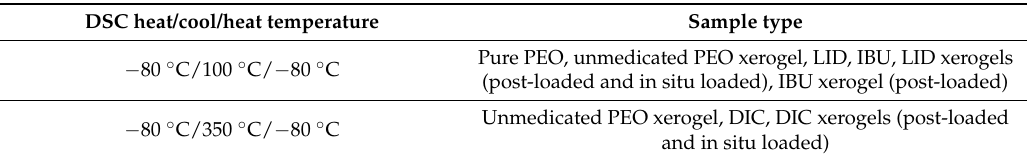
Table 2. DSC temperature